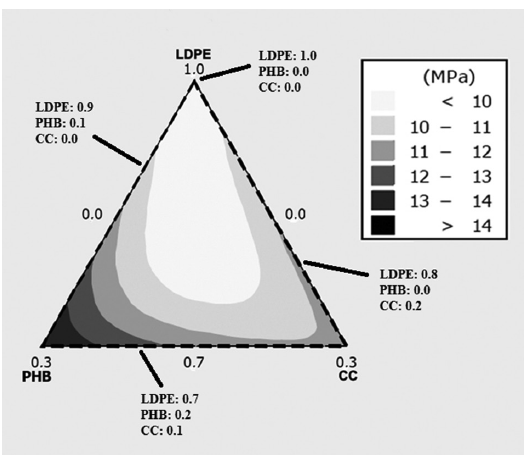
Figure 2. Response surface plot of flexural strength (MPa).